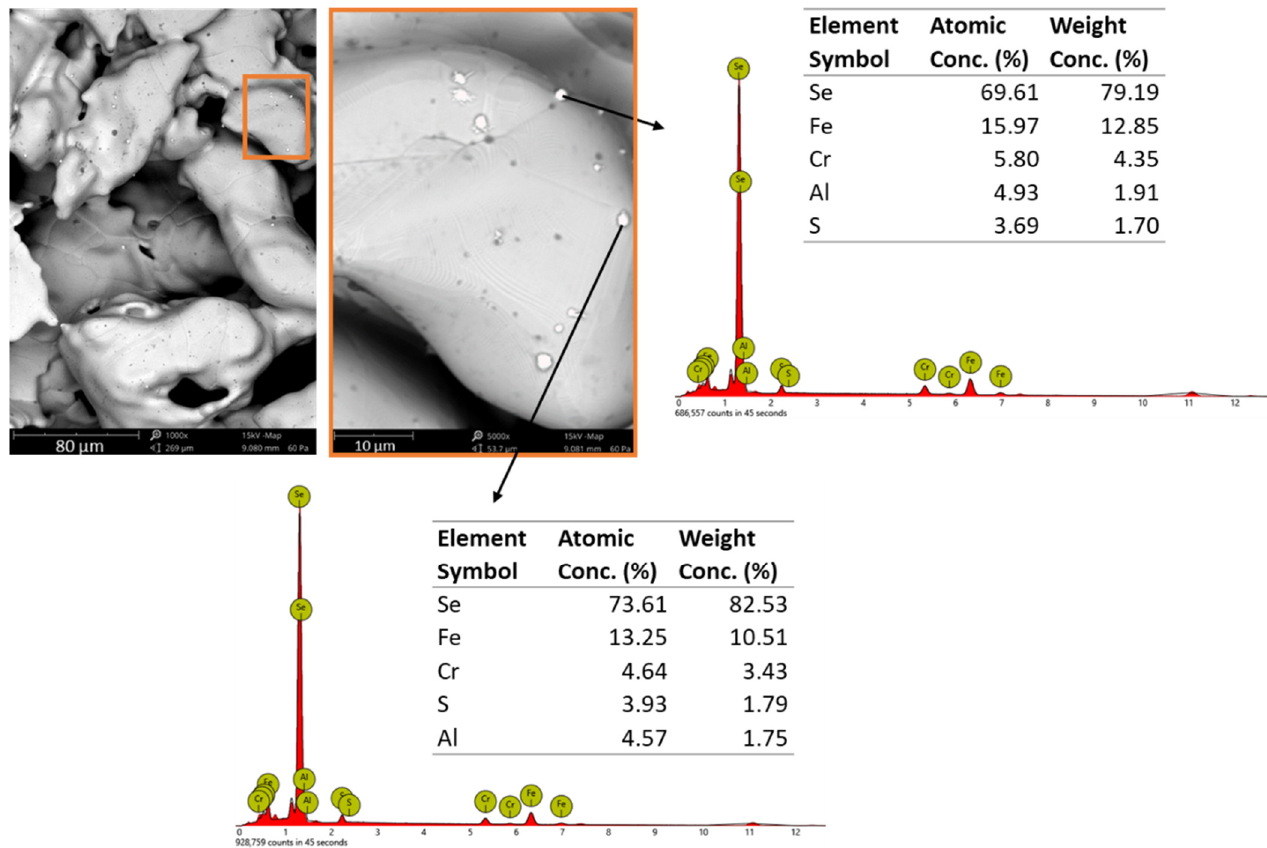
Figure 3. SEM–EDX images of the stainless steel filter surface of batch test Ab_Se(IV)-CF_a. EDX spot analyses were performed on distinct deposits. For EDX analysis, elements Bi, Br, Dy, I, Re, Sb, Sr, Te, Ti, V and W were disabled. The scale bar is shown in the bottom left corner of each SEM image.